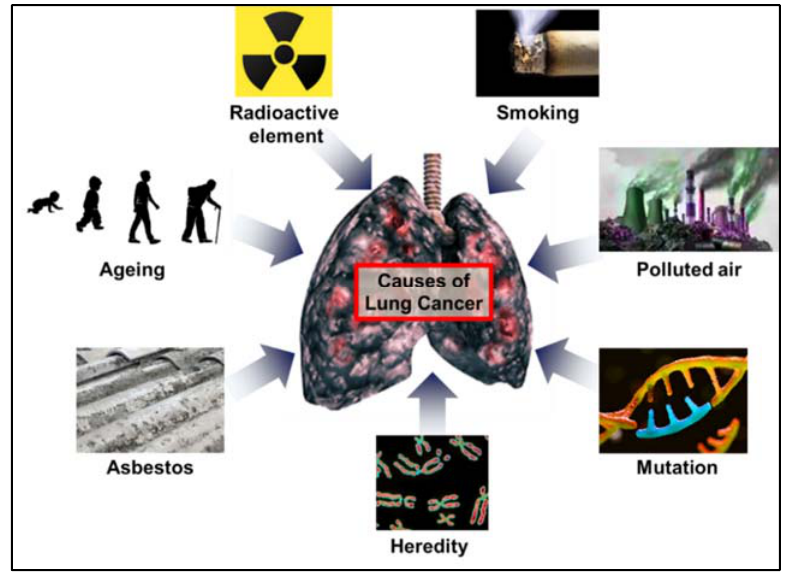
Figure 1. Common risk factors for lung cancer. Table 1. Comparison between small cell lung carcinoma and nonsmall cell lung